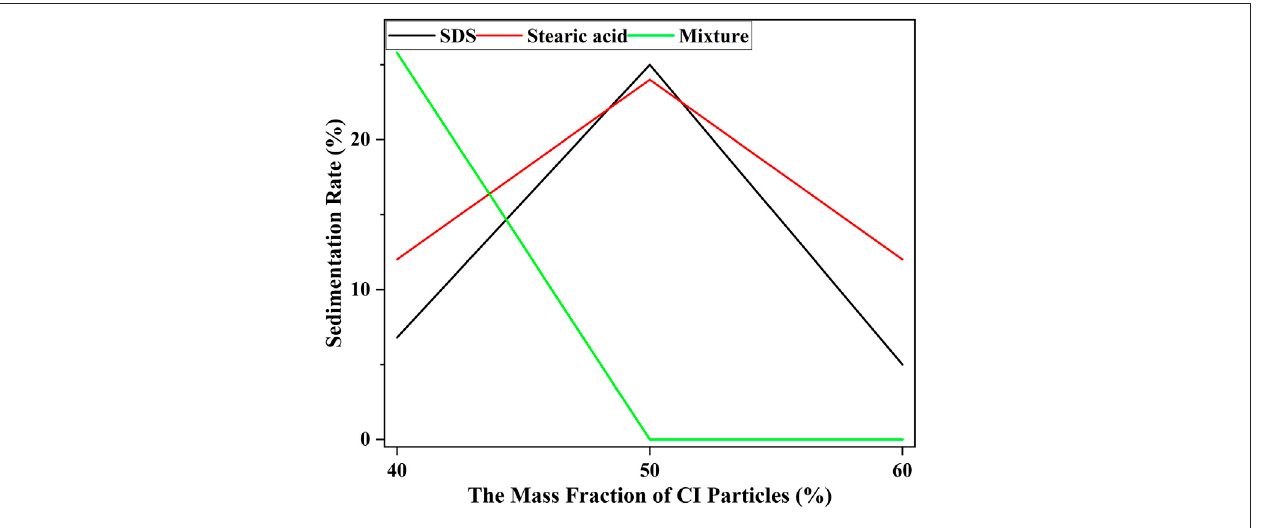
FIGURE 10 | The change of sedimentation rate with the mass fraction of CI